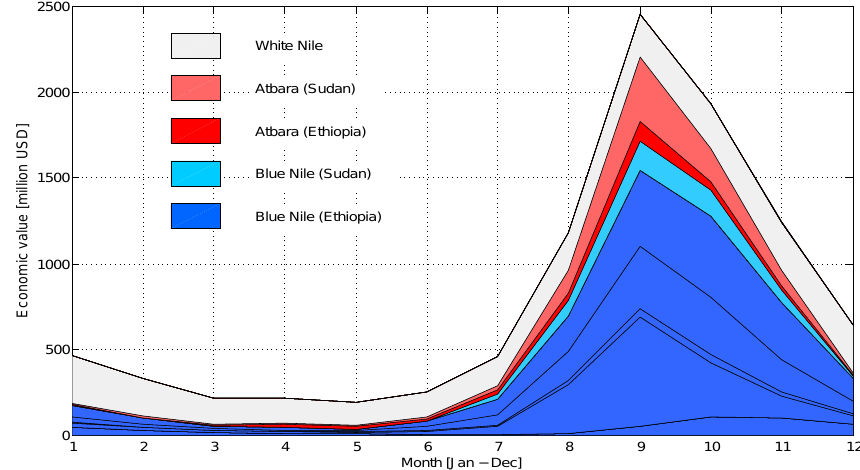
Figure 6. Average monthly values of blue water in the